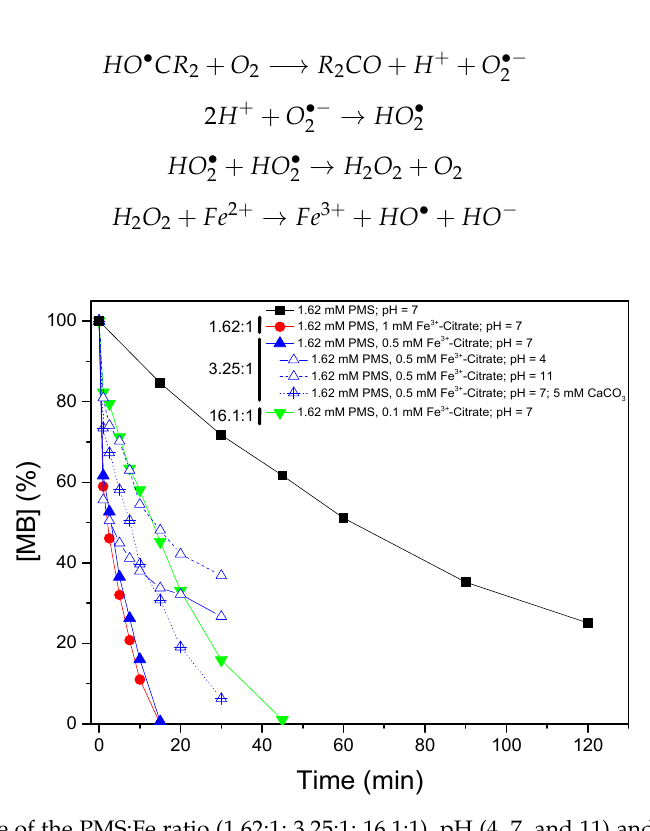
Figure 4. Influence of the PMS:Fe ratio (1.62:1; 3.25:1; 16.1:1), pH (4, 7, and 11) and the presence of scavenger substances (5 mM CaCO 3 ) on MB decolouration through PMS photocatalytic activation with Fe 3+ -citrate and UV-A radiation.